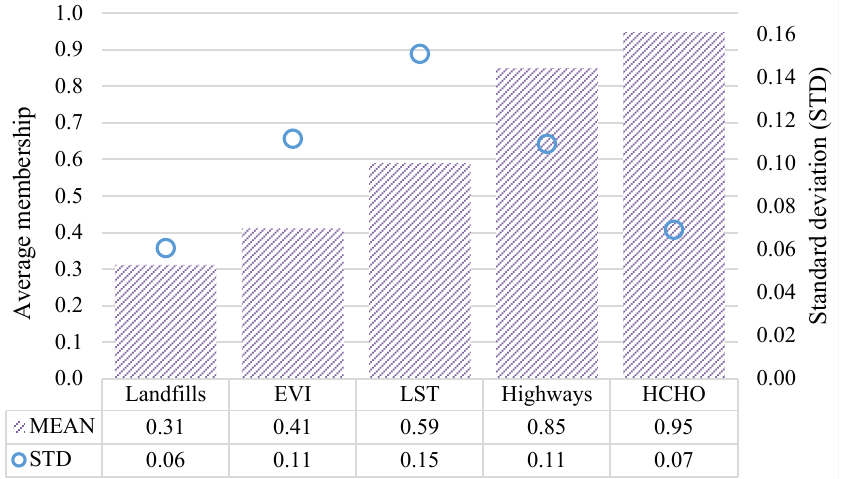
Figure 5. Zonal statistics of five variables and their contributions to PIDS occurrence.